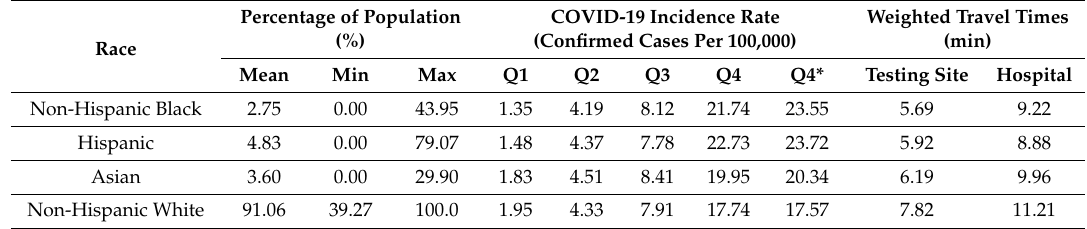
Table 2. COVID-19 incidence rate and health access across racial population in city / town level.